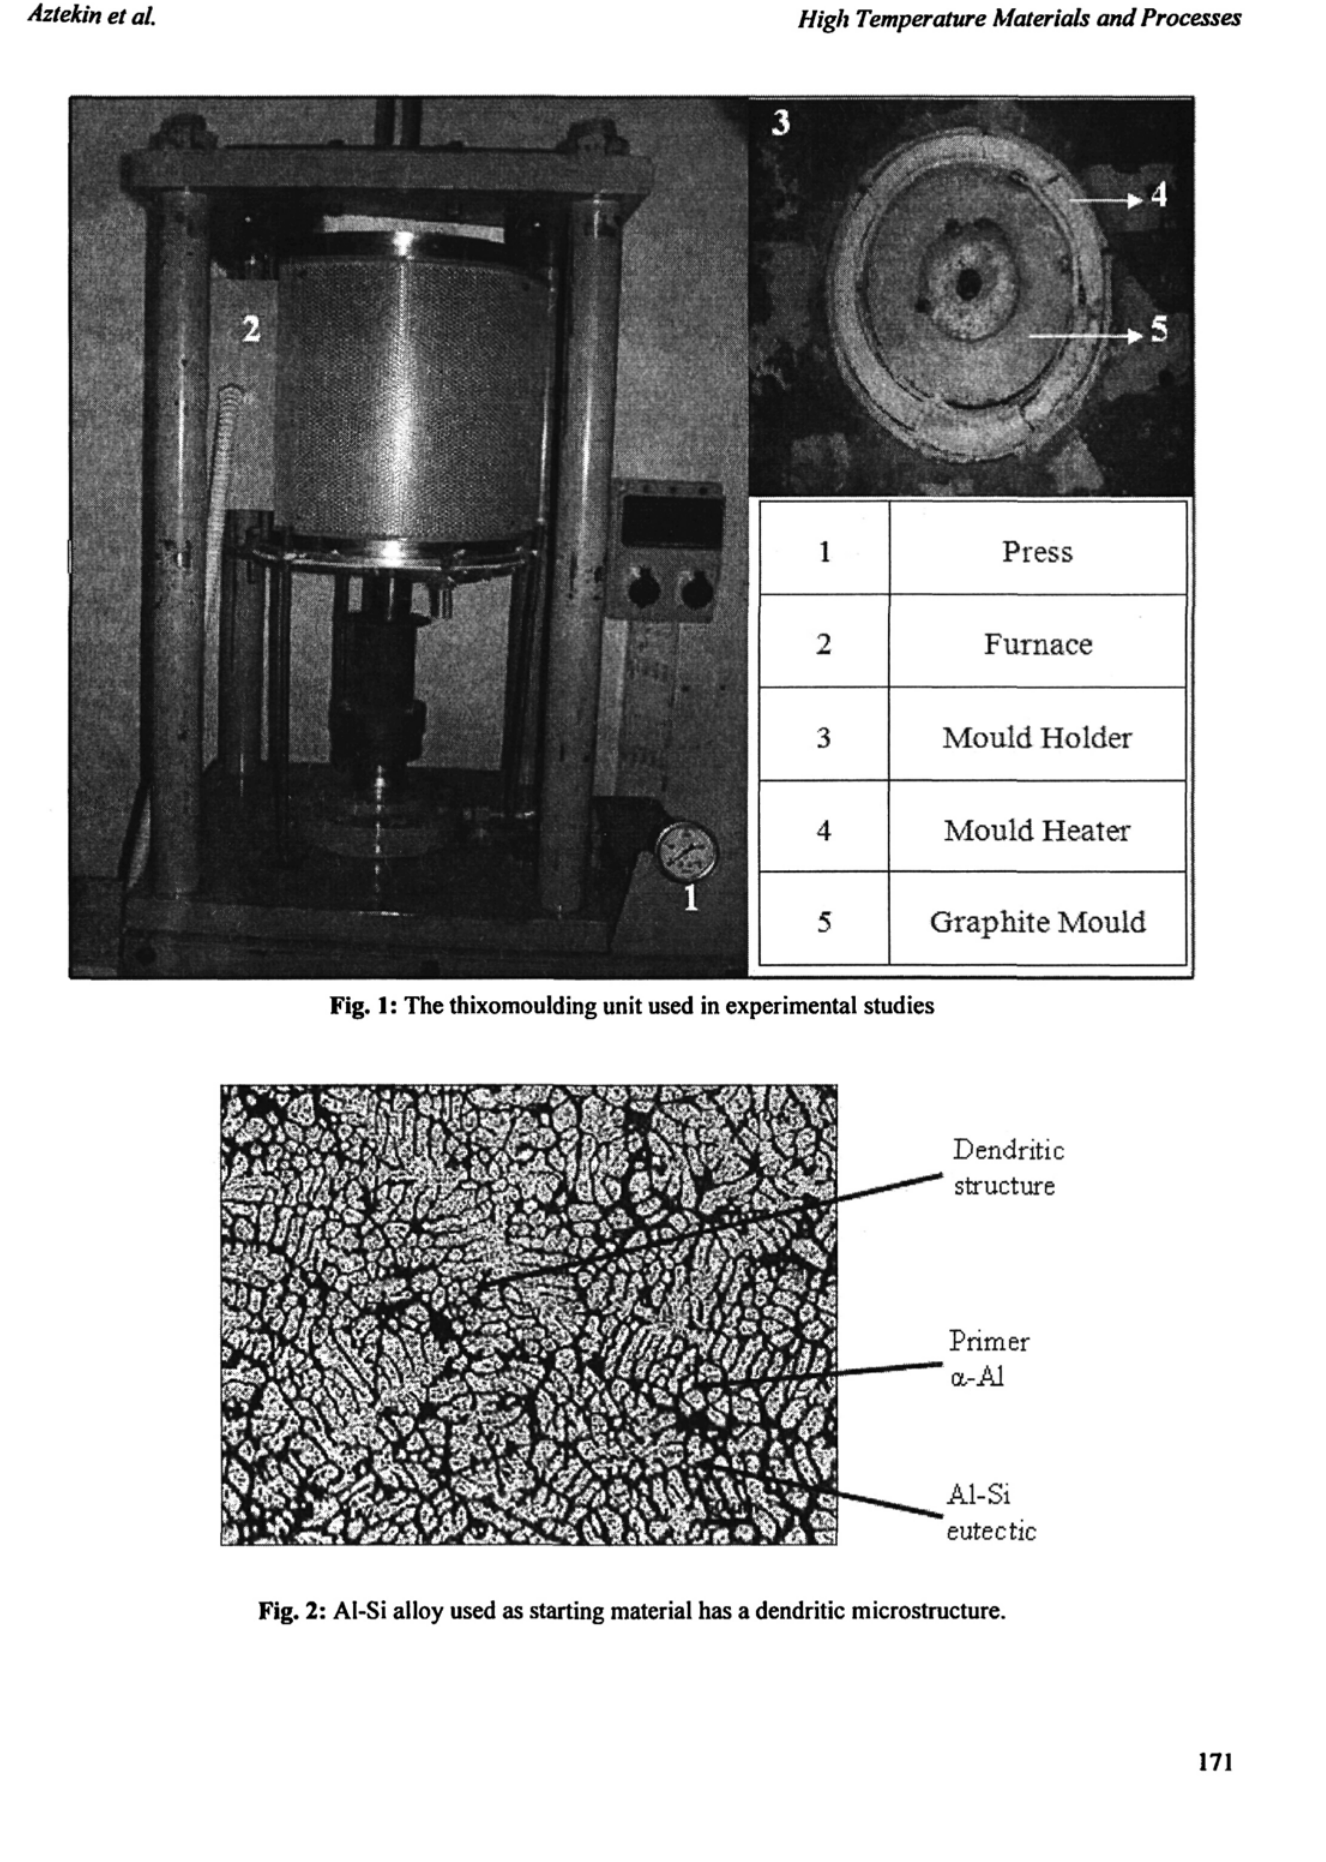
Fig. 2: ΑΙ-Si alloy used as starting material has a dendritic microstructure.